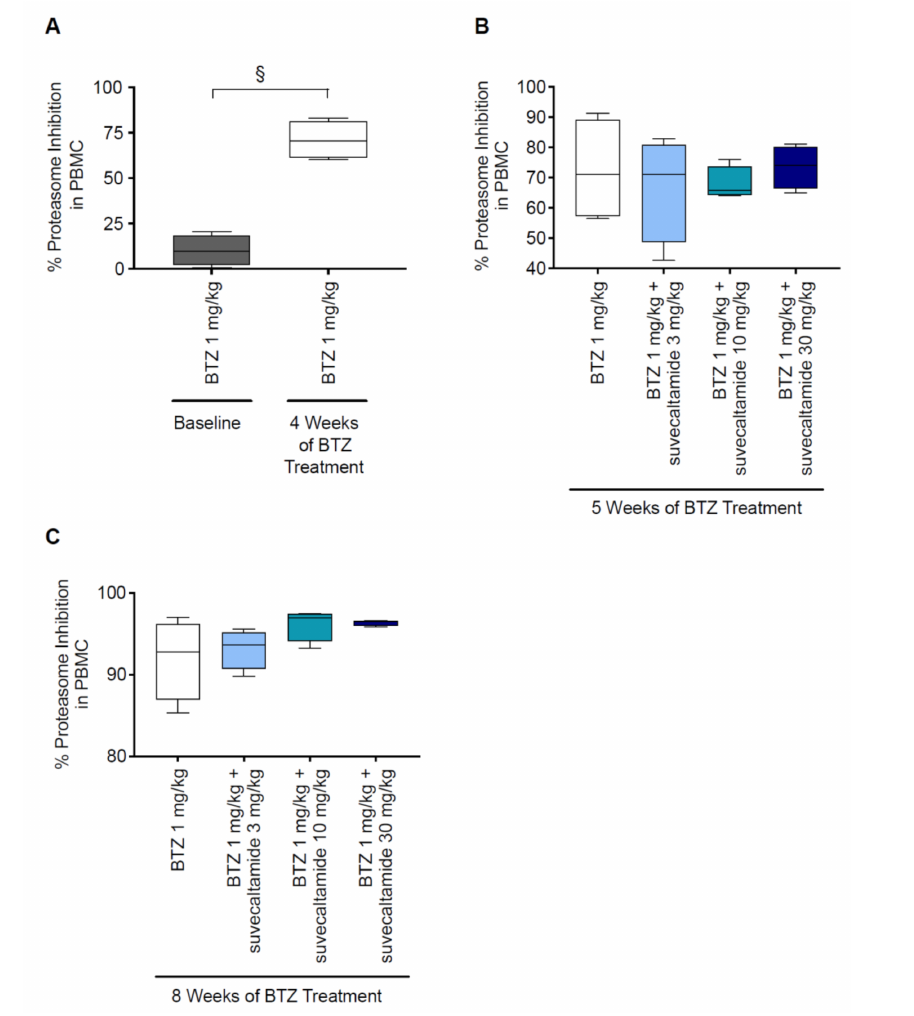
Figure 5. Proteasome inhibition. Percent proteasome inhibition in PBMCs isolated from rats in the BTZ-induced CIPN rat model at ( A ) 4 weeks, ( B ) 5 weeks, and ( C ) 8 weeks. BTZ—bortezomib; CIPN—chemotherapy-induced peripheral neurotoxicity; PBMC—peripheral blood mononuclear cell. § p < 0.05 vs. BTZ